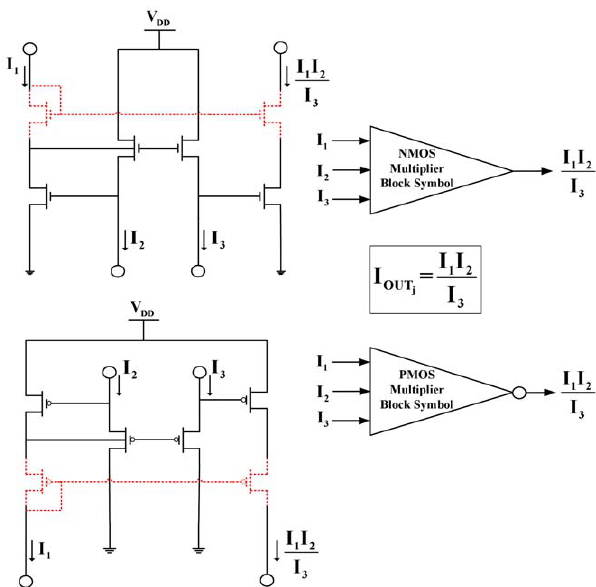
Figure 4. Schematic and symbolic representation of the multiplier/divider TL block. Note that both blocks presented in this Figure are cascoded TL blocks. Depending on the accuracy required for each application, CytoMimetic circuits can operate with non- cascoded multiplier TL blocks. The symbolic representation for the non- cascoded multiplier is similar to the one presented here but with a star placed inside the symbol (see for example Figure 6). In the non- cascoded topology, the devices that are sketched with dashed lines are absent.